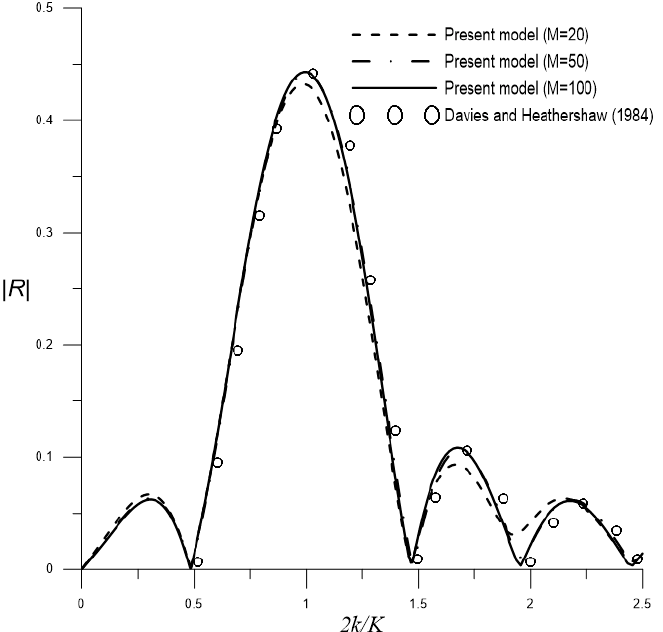
Figure 7. Reflection coefficient | R | varying against 2 k / K for wave be scattered by sinusoidal bottom topography.